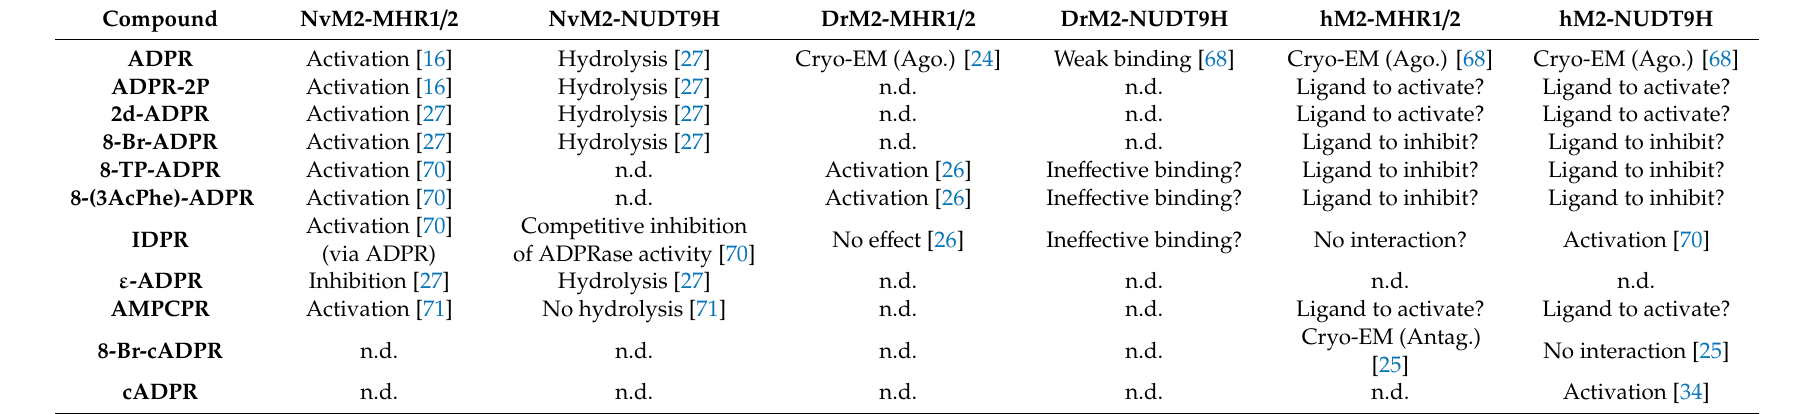
Table 2. Substrate specificities of the two ADPR binding pockets in di ff erent species variants of TRPM2 (transient receptor potential melastatin type 2 cation channel) as derived from the currently available data. Annotations that are derived indirectly without being experimentally confirmed have a question mark. The N-terminal ADPR binding pocket is synonymous with MHR 1 / 2 and the C-terminal ADPR binding pocket is synonymous with NUDT9H; n.d. not determined; Ago. agonist; Ant.